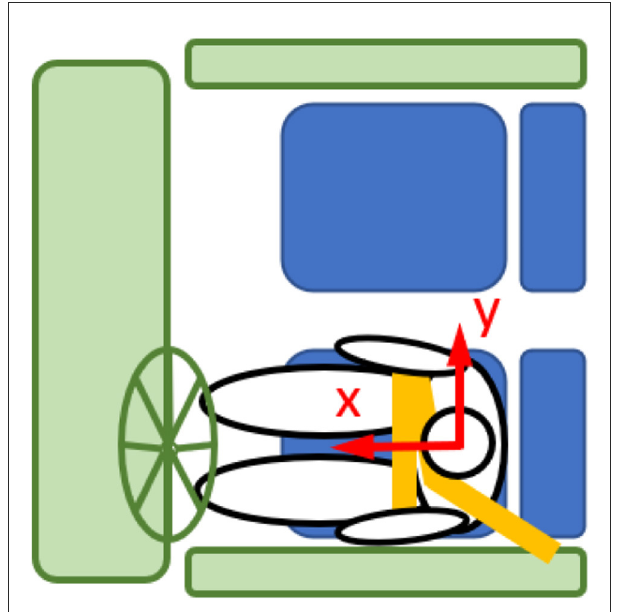
FIGURE5 Sketch of the Madymo vehicle interior with AHM positioned on the driver seat and attached seatbelt. The local coordinate system for measurement of the head displacement is located at the initial position of the center of gravity of the head and moves with the rigid vehicle.